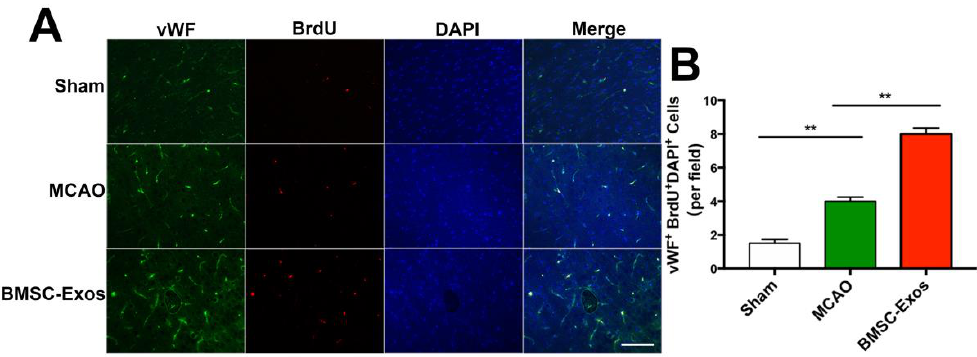
Figure 4. BMSC-Exos promoted angiogenesis in ischemic boundary zone. ( A ) Representative immunofluorescence images of the infarct boundary zone stained for vWF (green), BrdU (red) and DAPI (blue). Scale bar = 200 µ m. ( B ) Quantification of vWF + /BrdU + /DAPI + microvascular endothelial cells. n = 6/group. ** p < 0.01. vWF, von Willebrand factor; BrdU, 5-bromo-2-deoxyuridine; DAPI, 4′ ,6-diamidino-2-phenylindole; BMSC-Exos, bone marrow mesenchymal stem cell-derived exosomes; MCAO, middle cerebral artery occlusion.